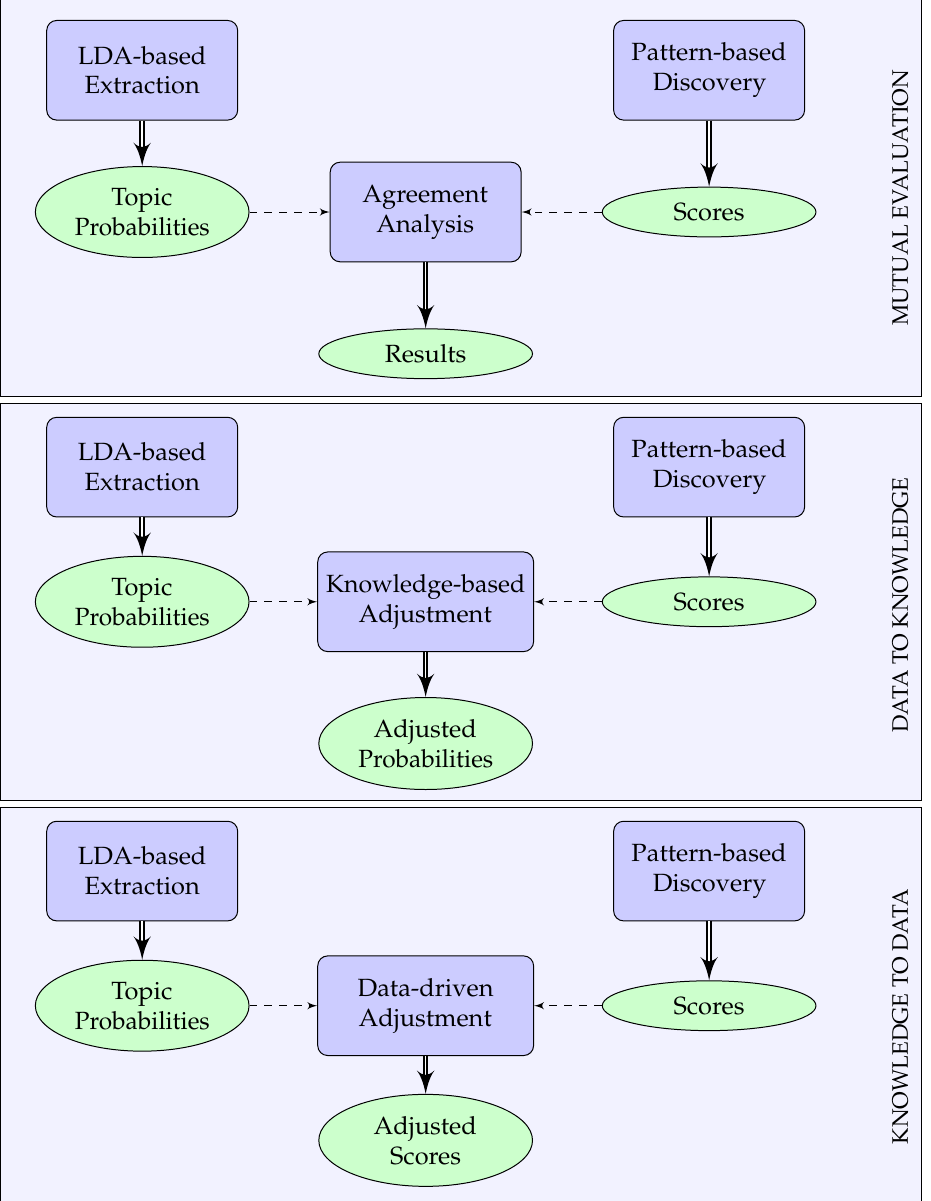
Figure 1. Overview of the proposed framework fusing knowledge-based and data-driven approaches. Latent Dirichlet allocation